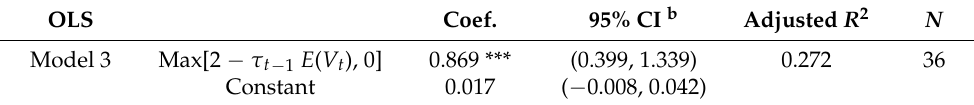
Table 2. Estimation results of models to explain a projected increase in cigarette tax revenue a